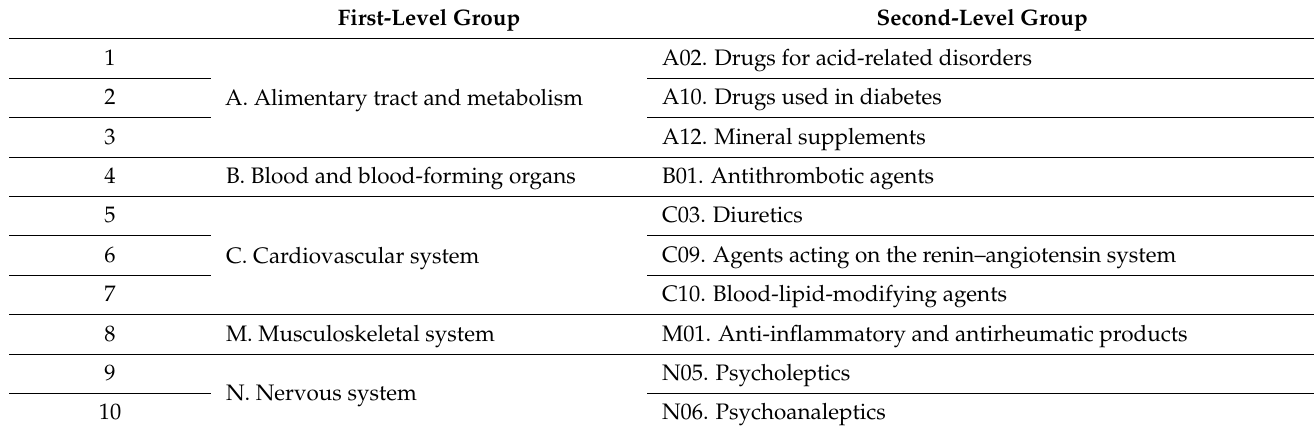
Table 1. The 10 most consumed drug groups in older Spanish